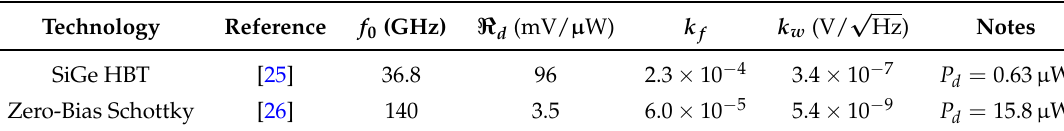
Table 6. Typical detector noise